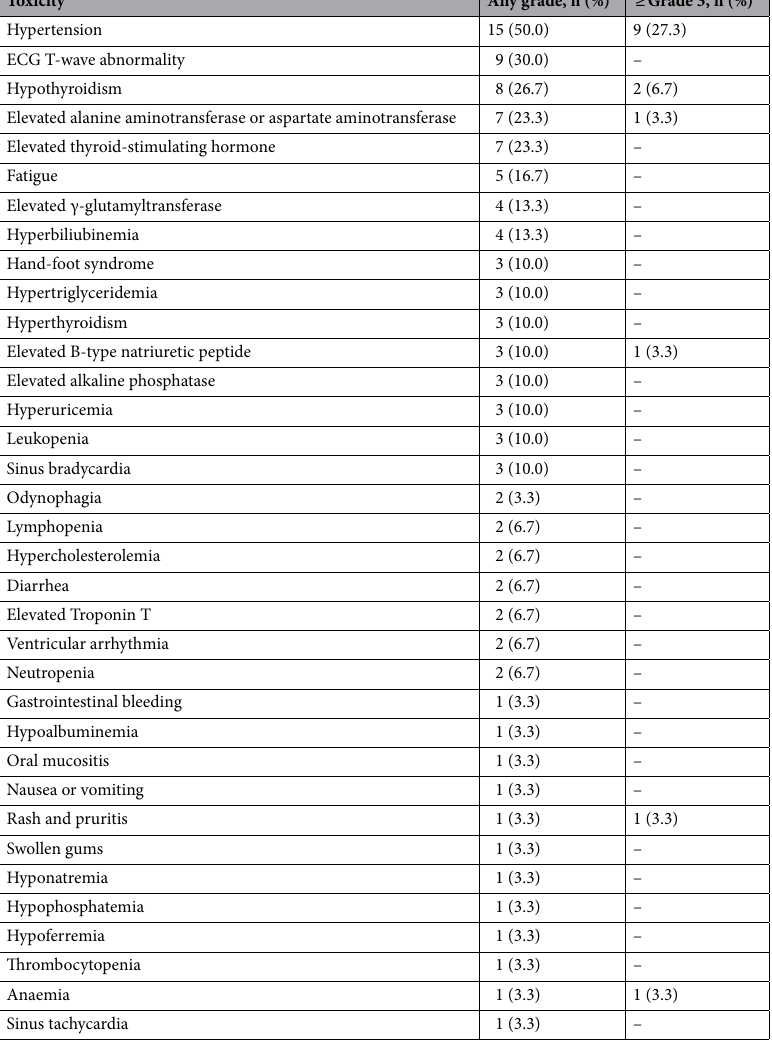
Table 2. Toxicity profile of 30 evaluable